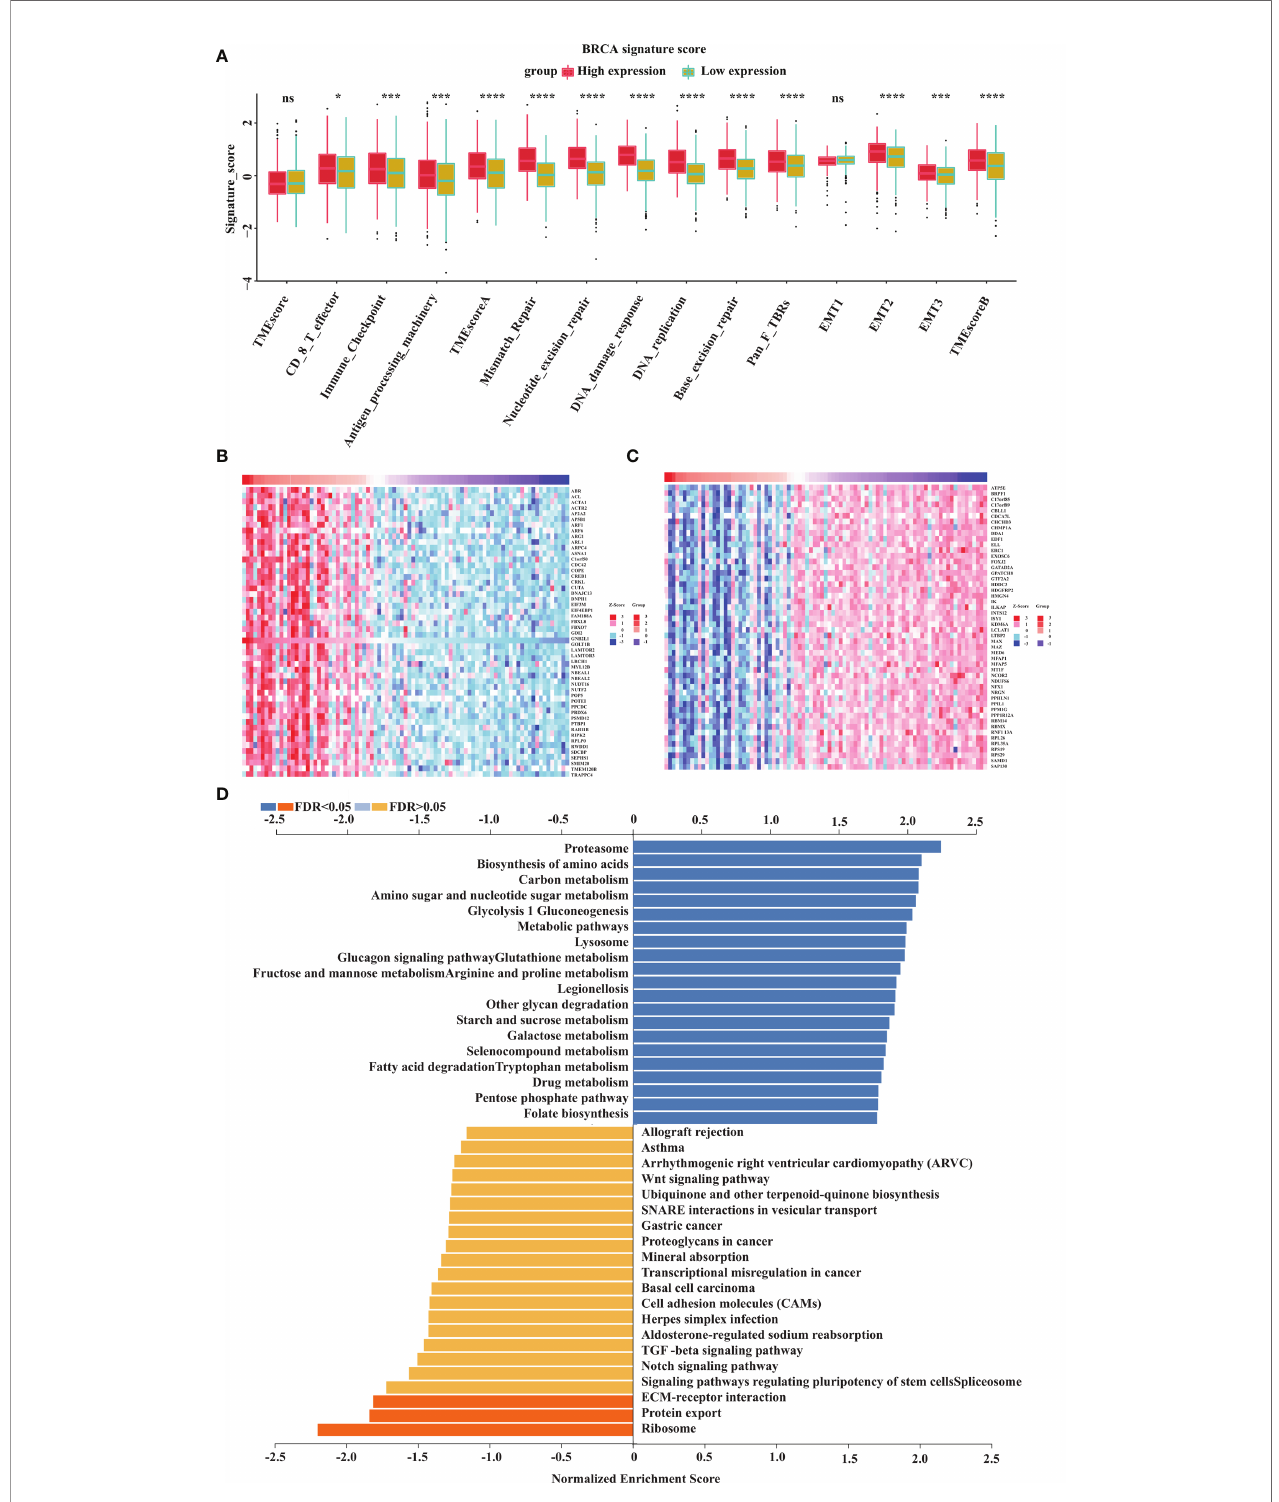
FIGURE 5 | GOLT1B potentially regulates the functionsof ribosome, proteasome and lysosome inhuman breast cancer. (A) The correlation between GOLT1B expression andgene signatures. In each group, the scattered dots represent the mean ofthe signature genes, andthe thick lines represent the median value. (B) Heat mapsof the top 50 genes positively correlated with GOLT1B expression. (C) Heat maps of the top 50 genes negatively correlated with GOLT1B expression. (D) GSEA analysis showing the positivelyand negatively correlated pathwaysof GOLT1B expression. “ ns ” indicated nostatisticsigni fi cance, *p< 0.05, ***p < 0.001, ****p < 0.0001.